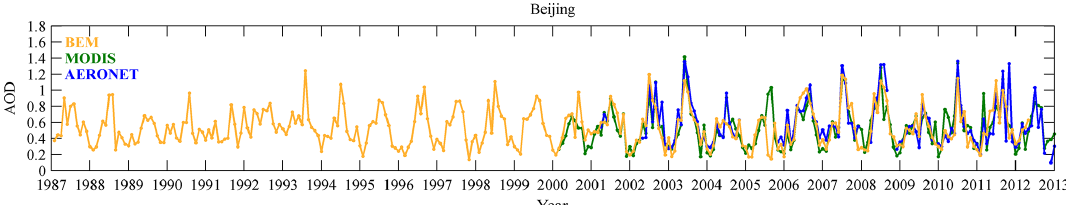
Figure 6. AOD time series for BEM (orange), with MODIS (green) and AERONET AOD (blue) as reference, over the Beijing site for the years